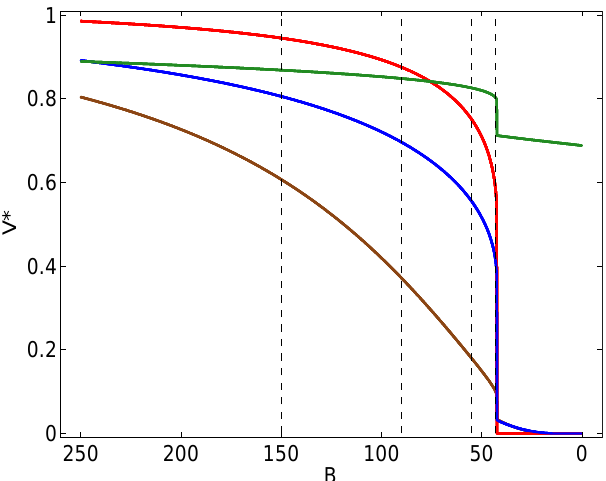
Fig. 5. Equilibrium vegetation cover at different elements of sys- tem 3 and for different bifurcation parameter values B . The colours correspond to the elements in Fig. 4. The vertical black dashed lines indicate the values of B used for the four stationary simulations (the smallest one also lying above the tipping point). They correspond to BV1 in Table 4 and are used for Figs. 7–11 and Table